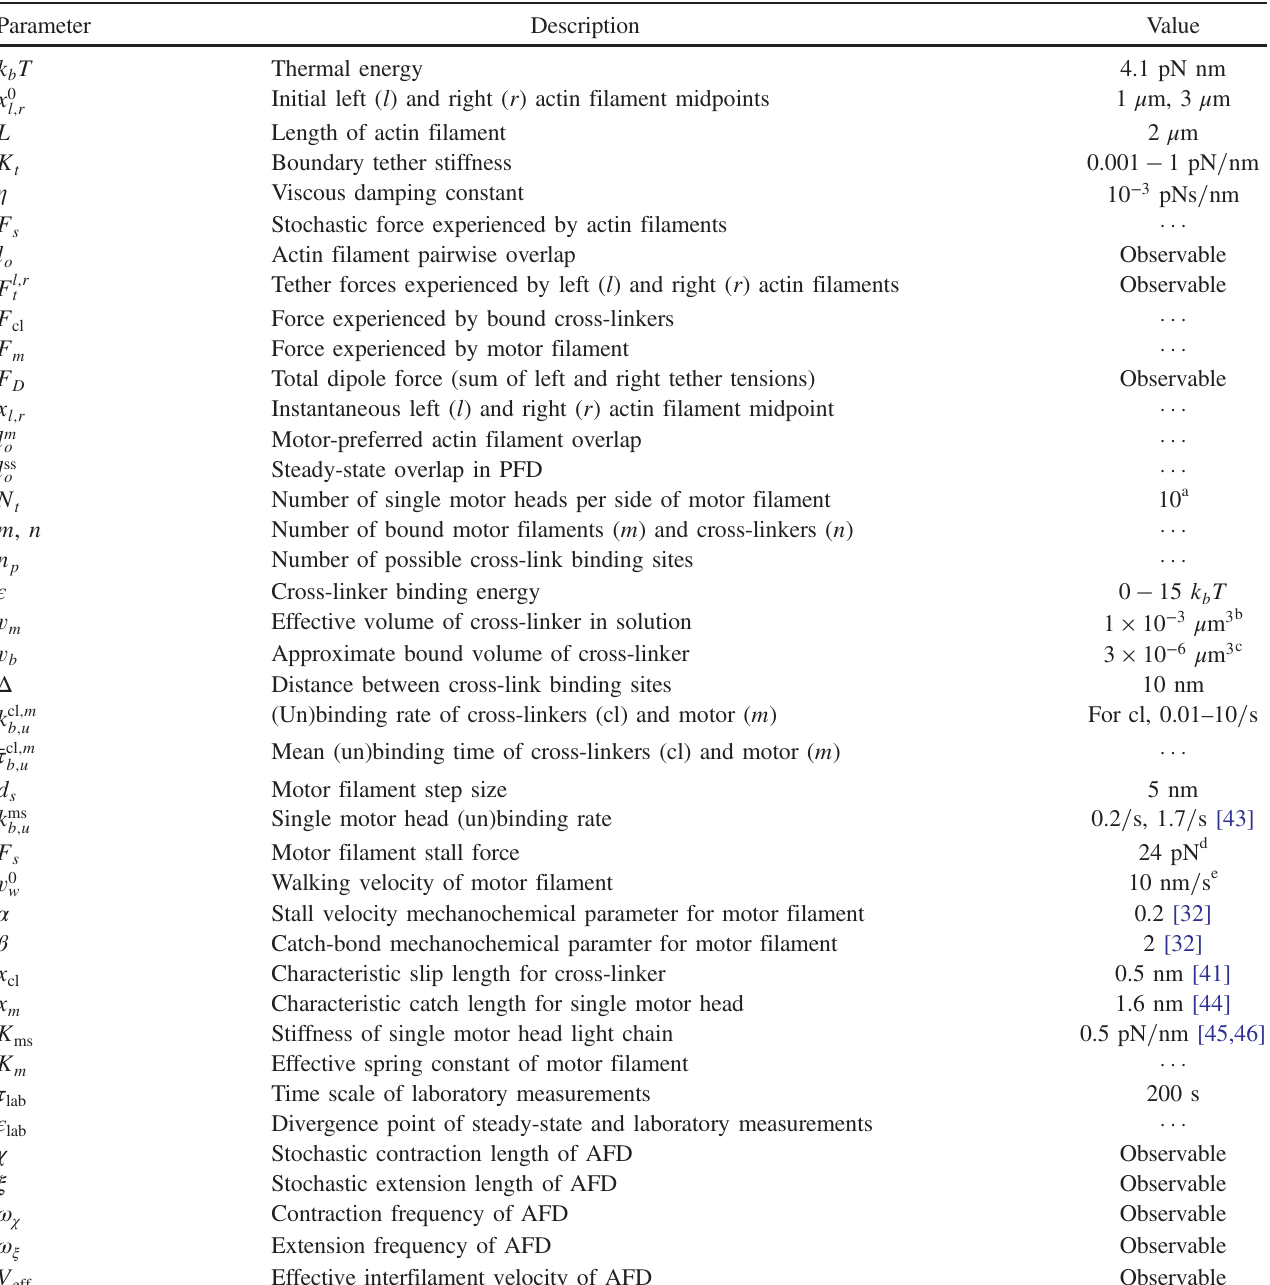
TABLE I. Glossary of variables and model parameters chosen to mimic a typical system of actin filaments, cross-linkers, and nonmuscle myosin IIA motor filaments in one